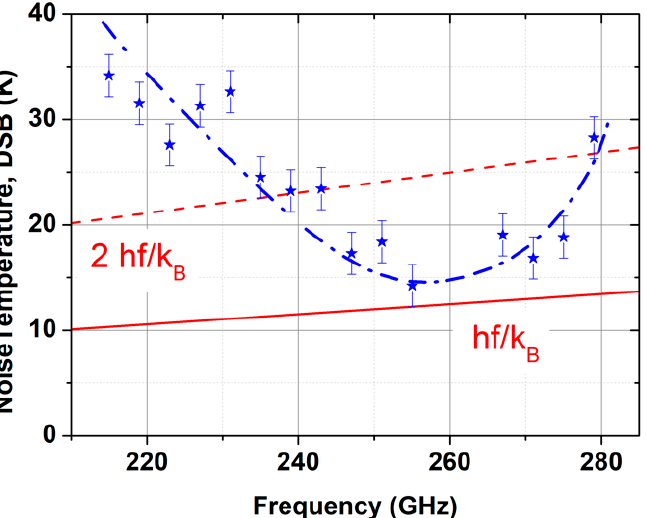
Figure 10. DSB receiver noise temperature of the SIS receiver on the local oscillator (LO) frequency; the experimental data are presented without any corrections for losses in the input optic elements. Measurement uncertainty is approximately 2 K, shown by error bars. The dash-dotted line is given as a guide for the eyes.